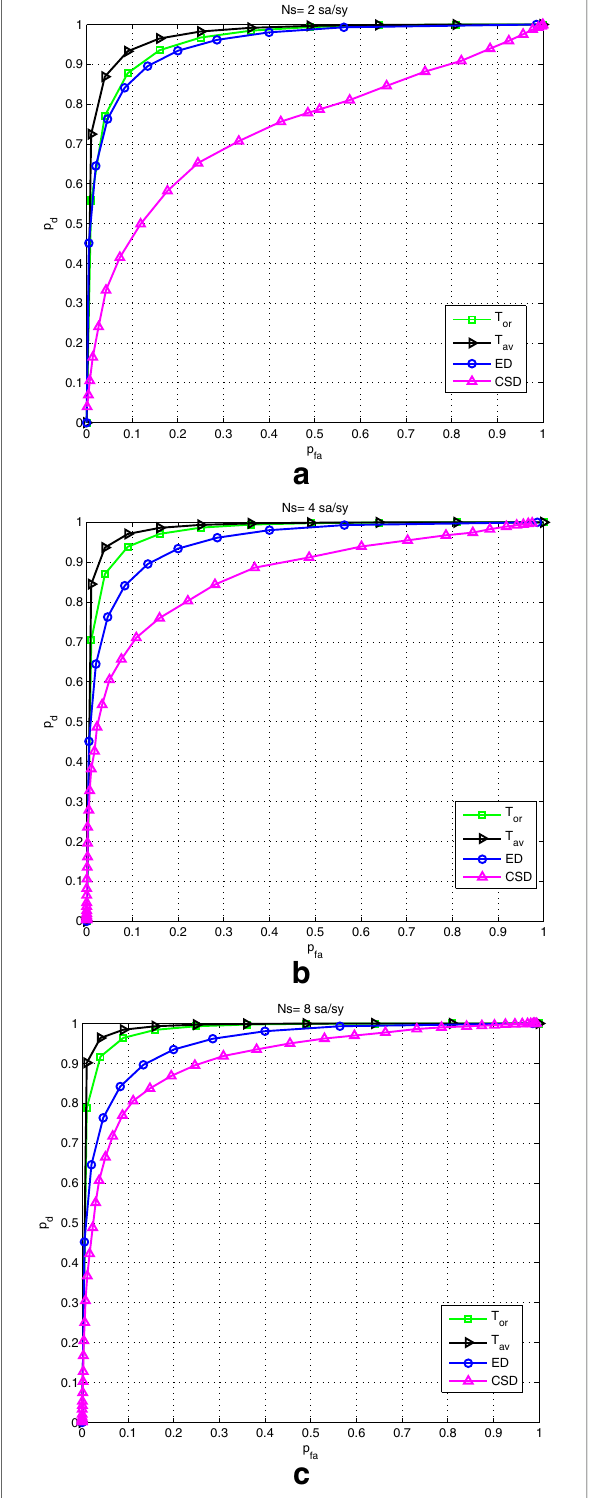
Fig. 6 Variation of the probability of detection in terms of SNR for N = 1000 samples, a constant p fa = 0.1, and various values of N s . a N s = 2 sps. b N s = 4 sps. c N s = 8